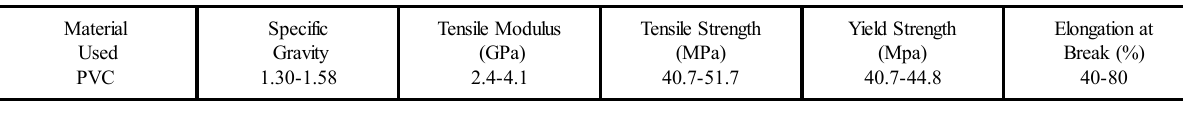
FIG. 1. STEPS OF PVC TABLE 1. SHOWING PROPERTIES OF PVC